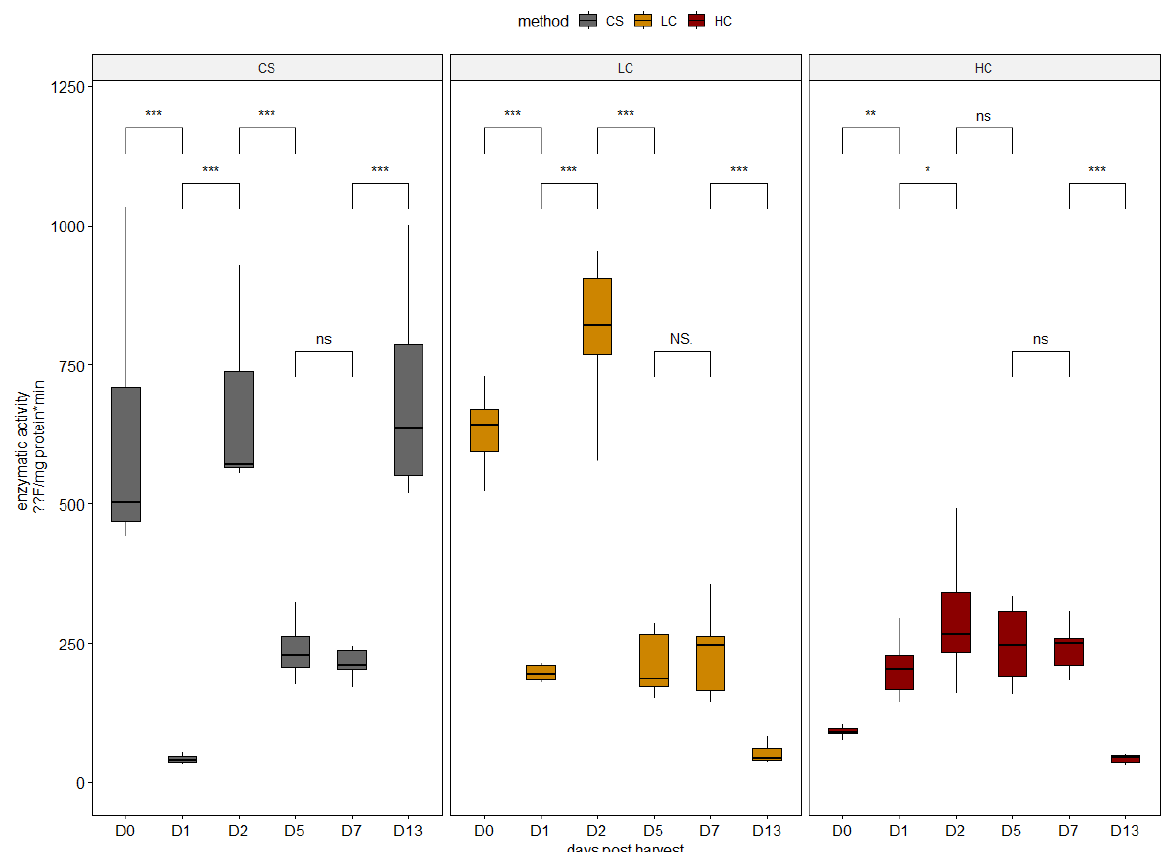
Figure 1. Enzymatic activity of calpain in all sampling days per harvest method. CS (gray): control group, LC (orange): low current group, HC (red): high current group. Superscripts indicate statisti- cally significant differences between sampling days in each harvest method (ns: p > 0.05, NS. = 1, *: p < 0.05, **: p < 0.01, ***: p < 0.001).